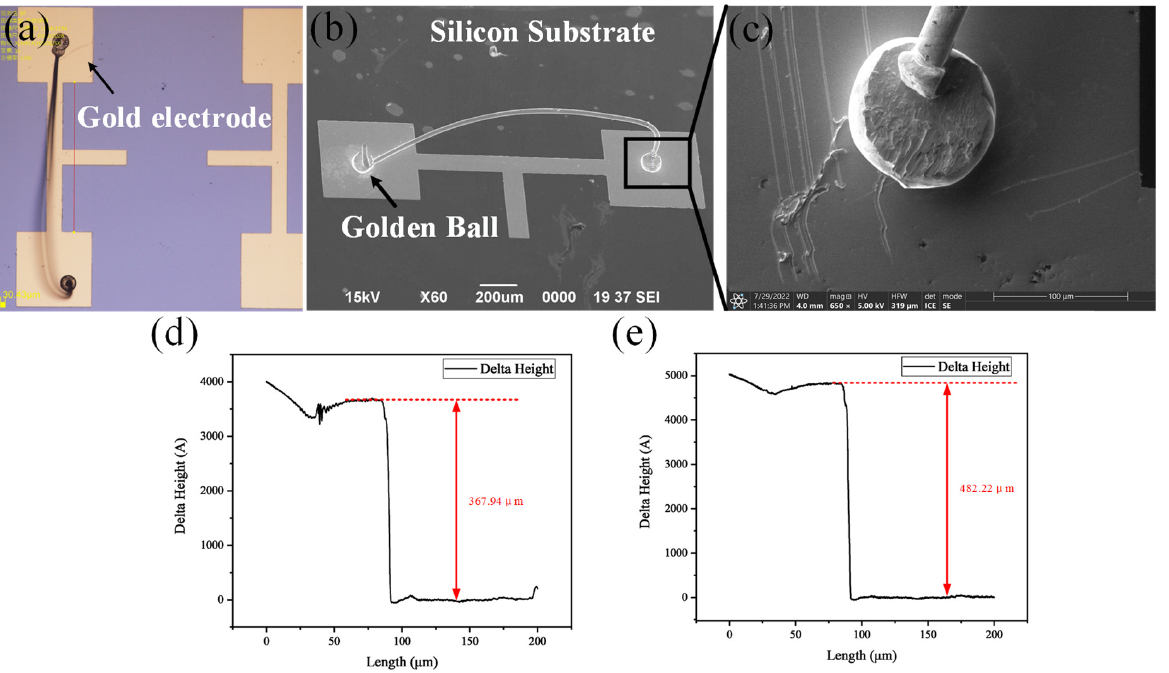
Figure 3. Analysis of interface and electrodes after ball bonding. ( a ) Photo of electrodes and in- tegrated bonding optical microscopy. ( b ) Scanning Electron Microscope Images of Electrodes and Global Bonding. ( c ) Interface Diagram of Spherical Welding under High Power Scanning Electron Microscope. ( d ) Measuring 50/300 nm thick Cr/Au electrodes with a step instrument. ( e ) Measuring 50/400 nm thick Cr/Au electrodes with a step